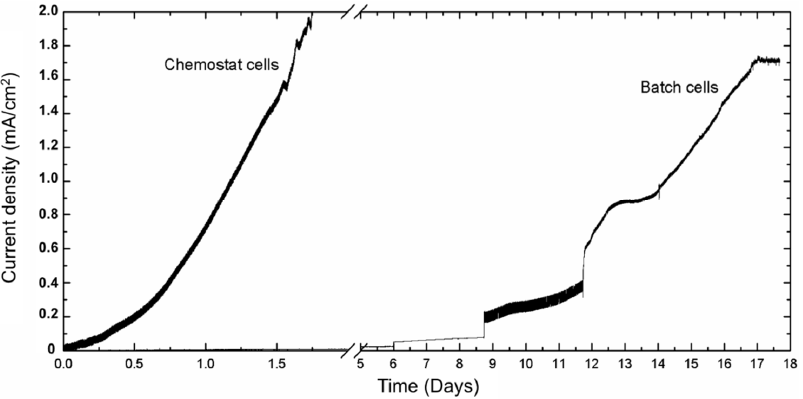
Figure 2. MEC start ‐ up operation using inoculum of steady ‐ state cells harvested from a chemostat Figure 2. MEC start-up operation using inoculum of steady-state cells harvested from a chemostat ( left ); or exponential phase cells from a batch culture ( right ). ( left ); or exponential phase cells from a batch culture ( right